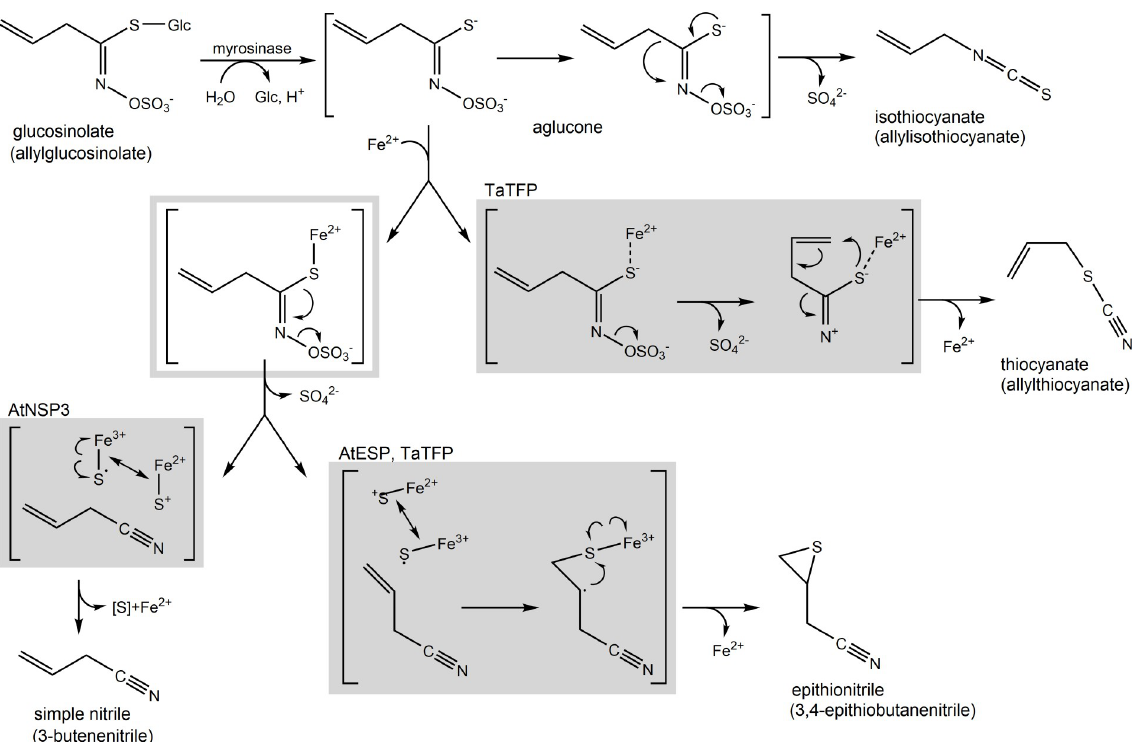
Fig 1. Glucosinolate breakdown pathways. Pathways are illustrated using allylglucosinolate as an example. Myrosinase-catalyzed glucosinolate hydrolysis yields an unstable aglucone that undergoes a spontaneous Lossen-like rearrangement to the isothiocyanate. In the presence of specifier proteins, alternative breakdown products (simple nitrile, epithionitrile, thiocyanate) are formed. Boxes indicate hypothetic mechanisms supposively mediated by specifier proteins. Specifier proteins analyzed in the present study are assigned to the boxes. If the aglucone lacks the structural requirements for epithionitrile and/or thiocyanate formation, all types of specifier proteins promote simple nitrile formation (not shown). For more detailed explanations, see text. Boxed reaction schemes are redrawn from [20] and [21] with modifications.